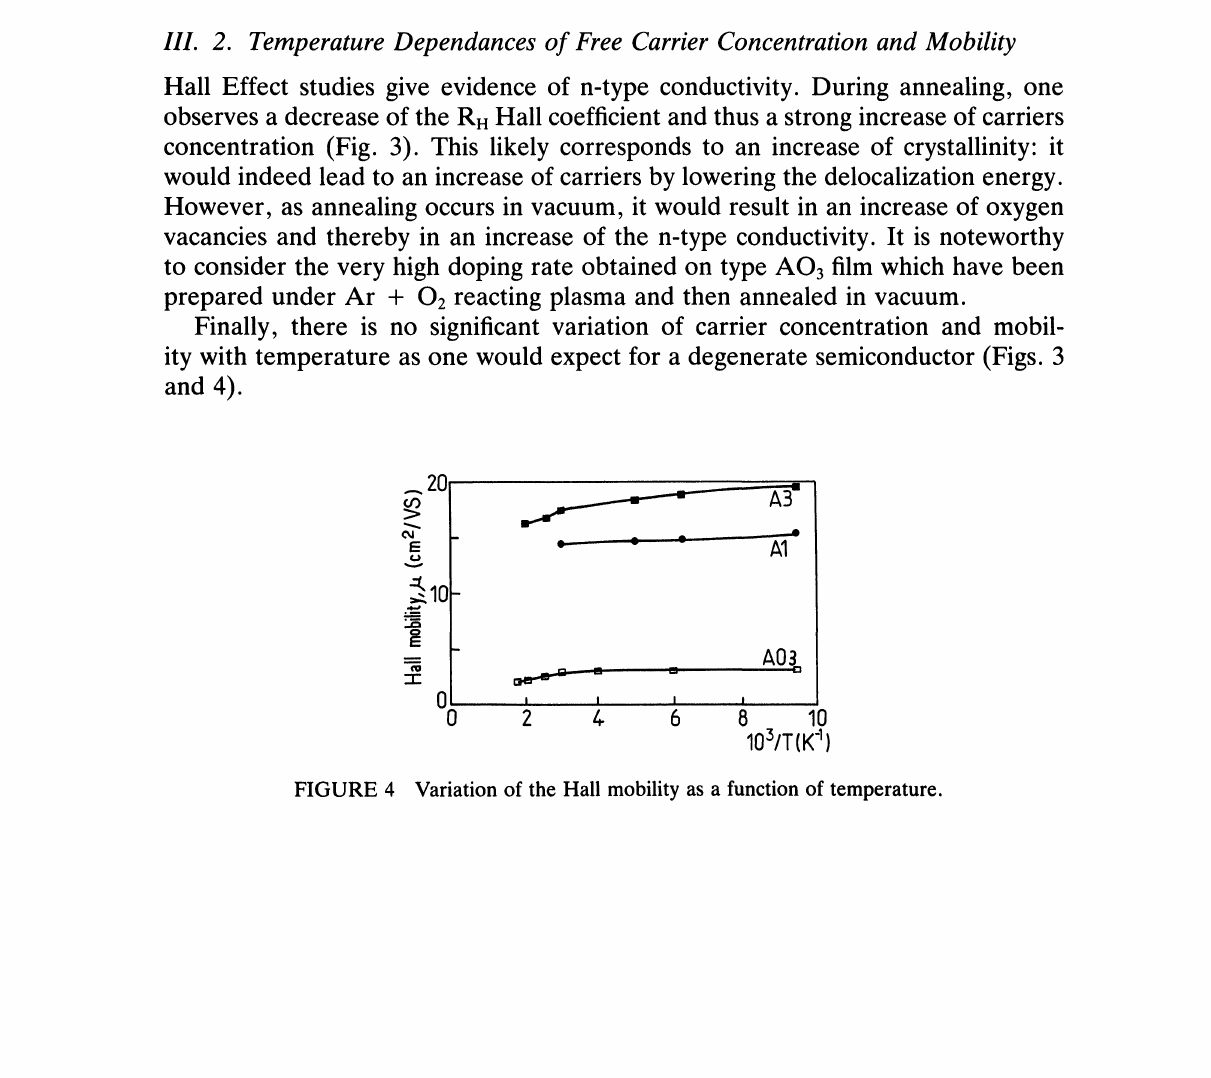
FIGURE 4 Variation of the Hall mobility as a function of